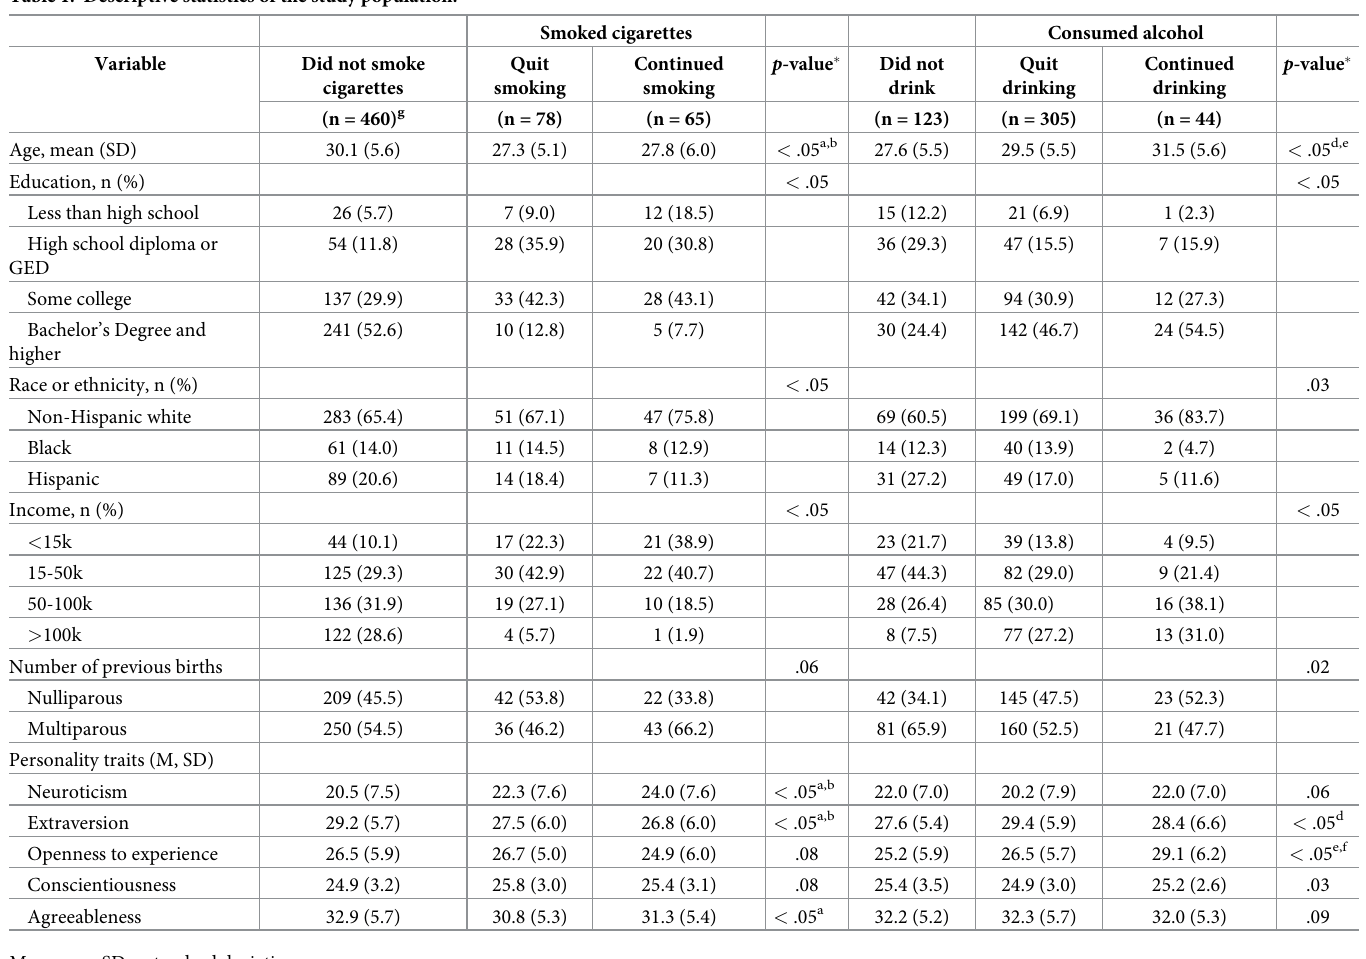
Table 1. Descriptive statistics of the study